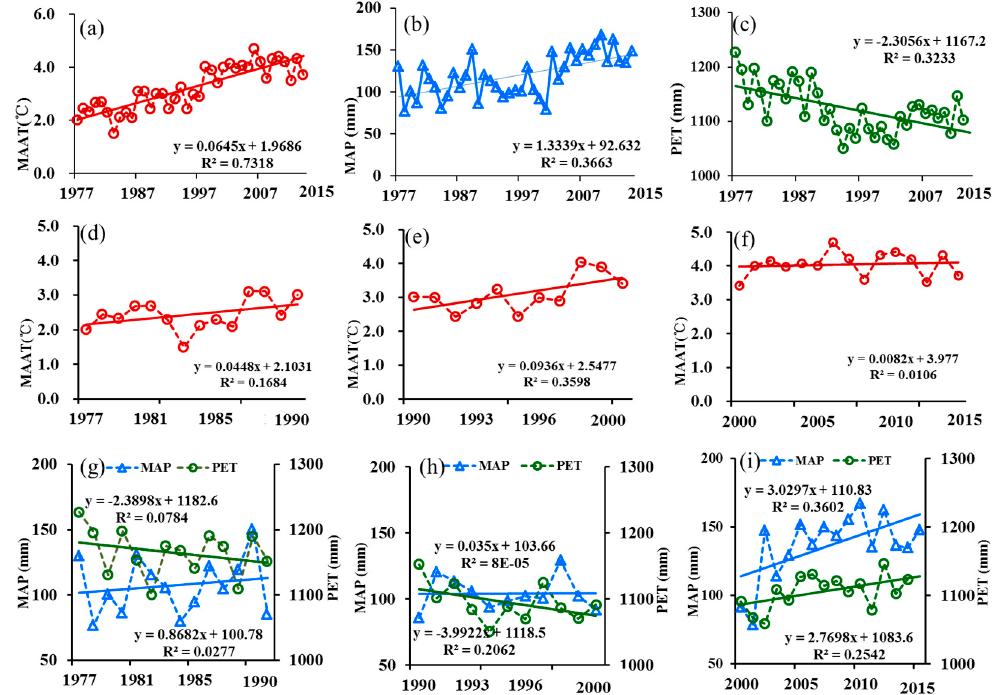
Figure 6. Annual variations in climatic factors. ( a – c ) represent annual changes in mean annual air temperature (MAAT), mean annual precipitation (MAP), and potential evapotranspiration (PET) in the Qaidam Basin (QB) between 1977 and 2015, respectively. ( d – f ) represent the annual changes in MAAT and ( g – i ) represent the annual changes in MAP and PET during the periods 1977–1990, 1990–2000, and 2000–2015, respectively.